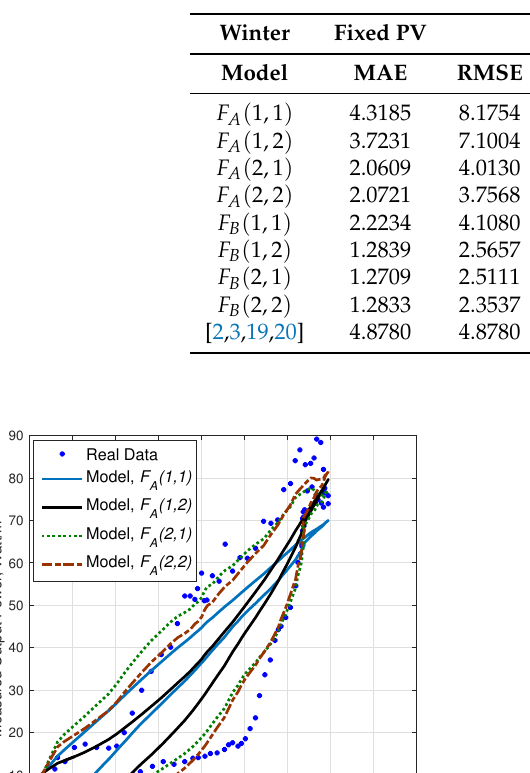
Table 6. MAE and RMSE values for fixed and tracking PV panel output power values (Watt) in Winter.